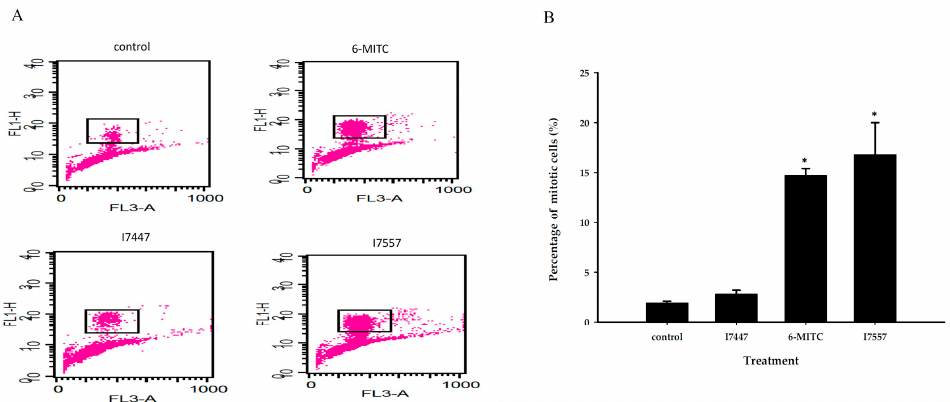
Figure 5. Phosphorylated histone H3 analysis of SAS cells treated with wasabi compound, 6-MITC, and its derivatives I7447 and I7557. After oral cancer SAS cells were treated with 6-MITC, I7447,